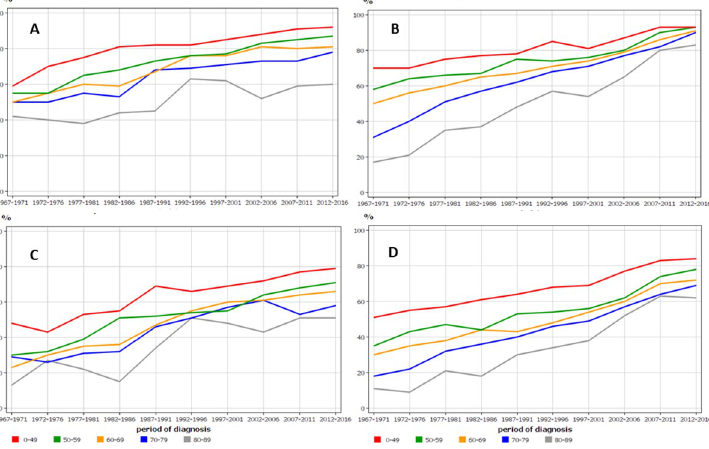
Fig 3. Age-specific 1-year relative survival for RCC in Finnish (A) and Swedish (B) men, and the related 5-year survival in the same male populations (C, D).